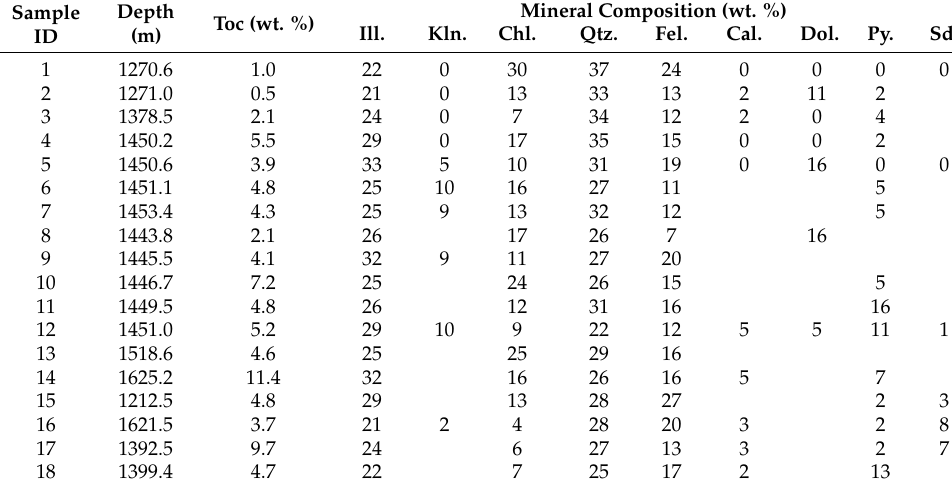
Table 1. Mineralogical composition analysis of the Chang 7 shale [20].